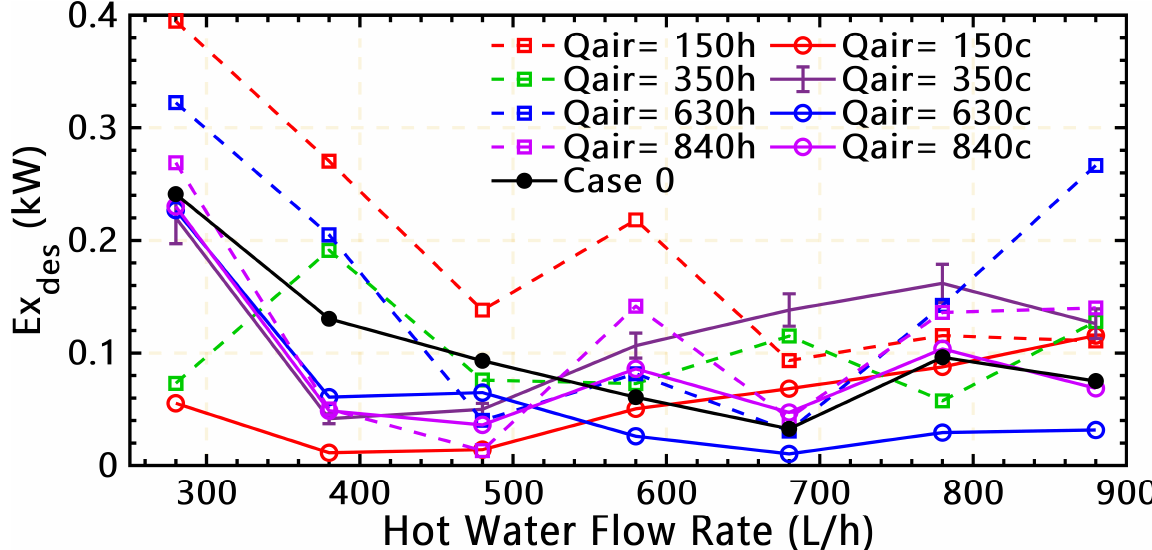
. Figure 11. 𝐸𝑥(cid:4662) (cid:3031)(cid:3032)(cid:3046) vs. 𝑄 (cid:3035) for original cases and different ABI into CWS and HWS. Ex des vs. Q h for original cases and different ABI into CWS and Figure 11.